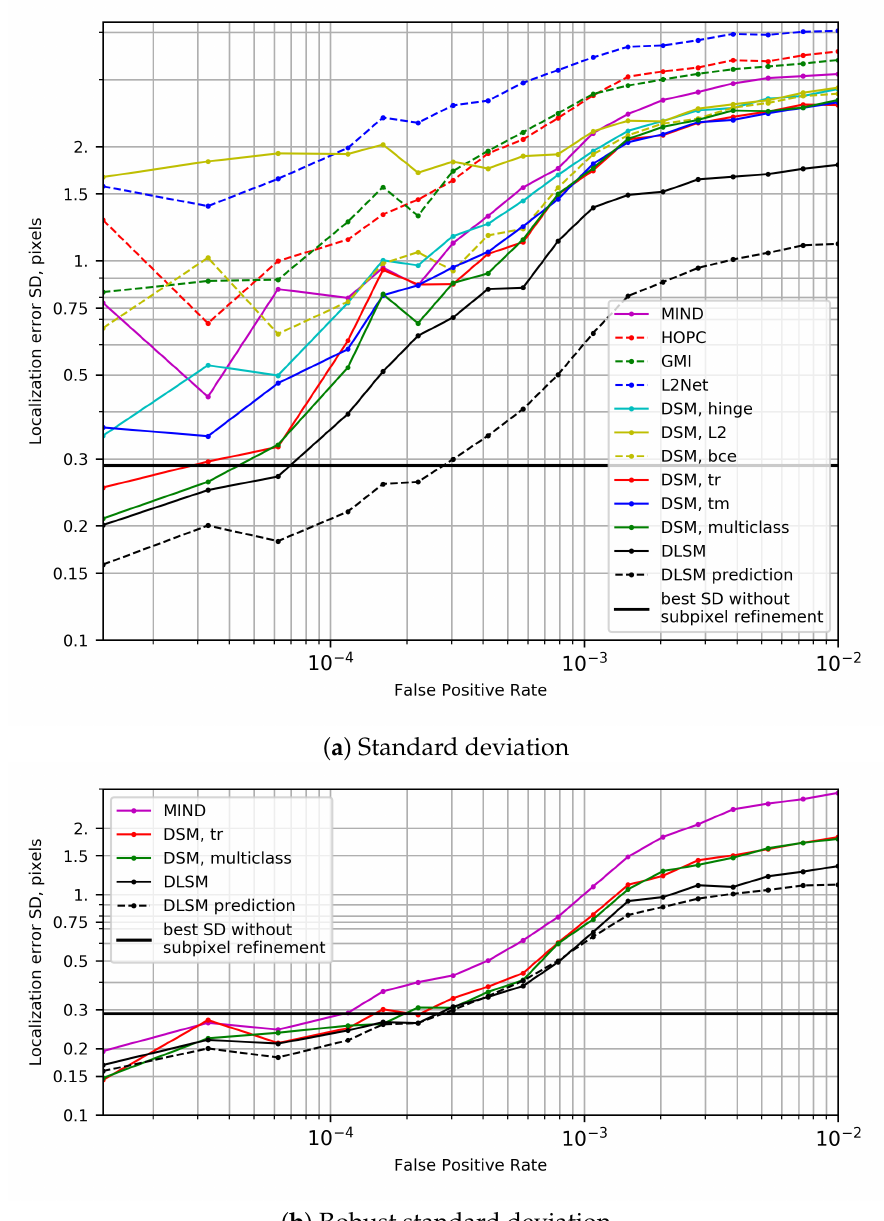
Figure 9. Localization error SD using Modality Independent Neighborhood Descriptor (MIND) as reference vs. SM